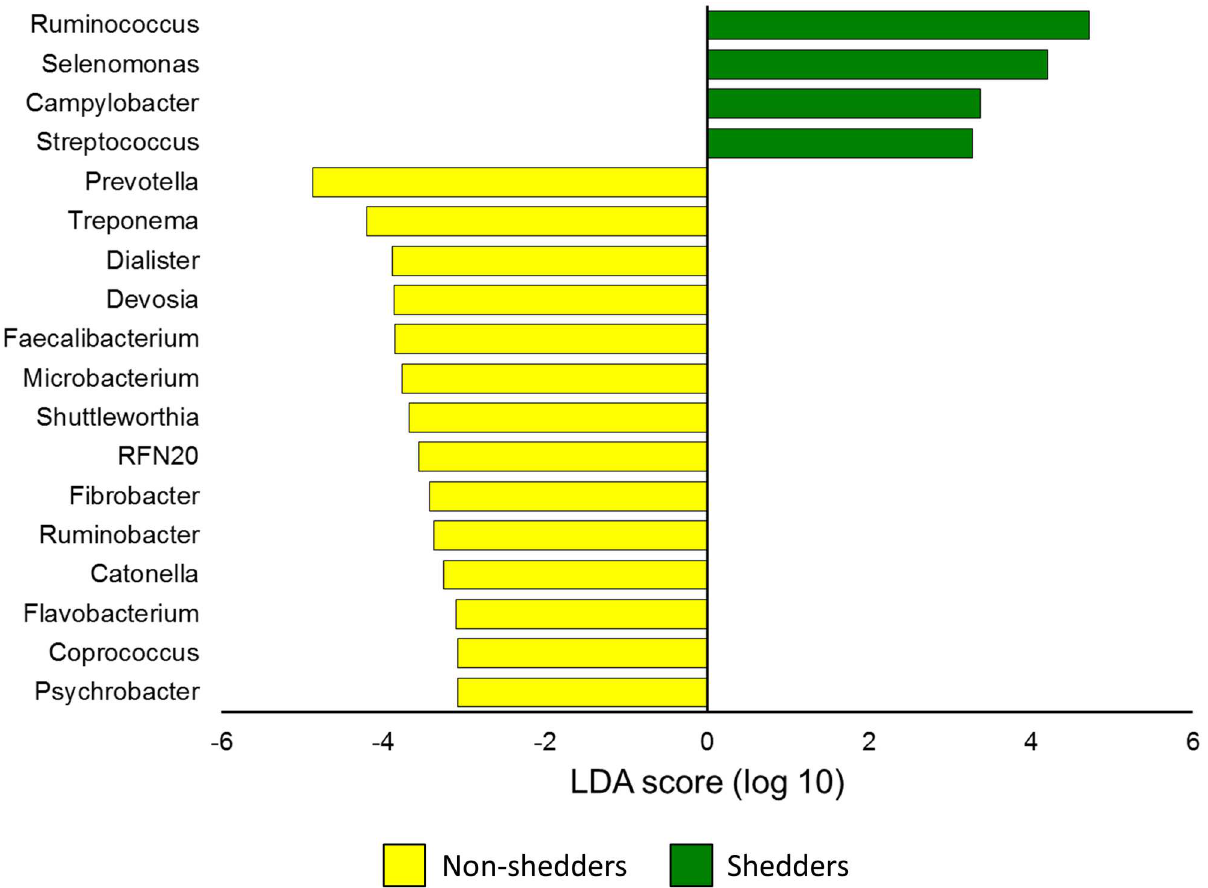
Fig 2. Differentially abundant genera associated with E . coli O157:H7 super-shedders as assessed using linear discriminant analysis effect size (LEfSe). Yellowbars indicate generaenriched in the non-sheddersamples (n = 39) and green bars represent genera enrichedin the sheddersamples(n = 41). Only generawith a LDA score [log 10 ] > 3.0 are displayed.